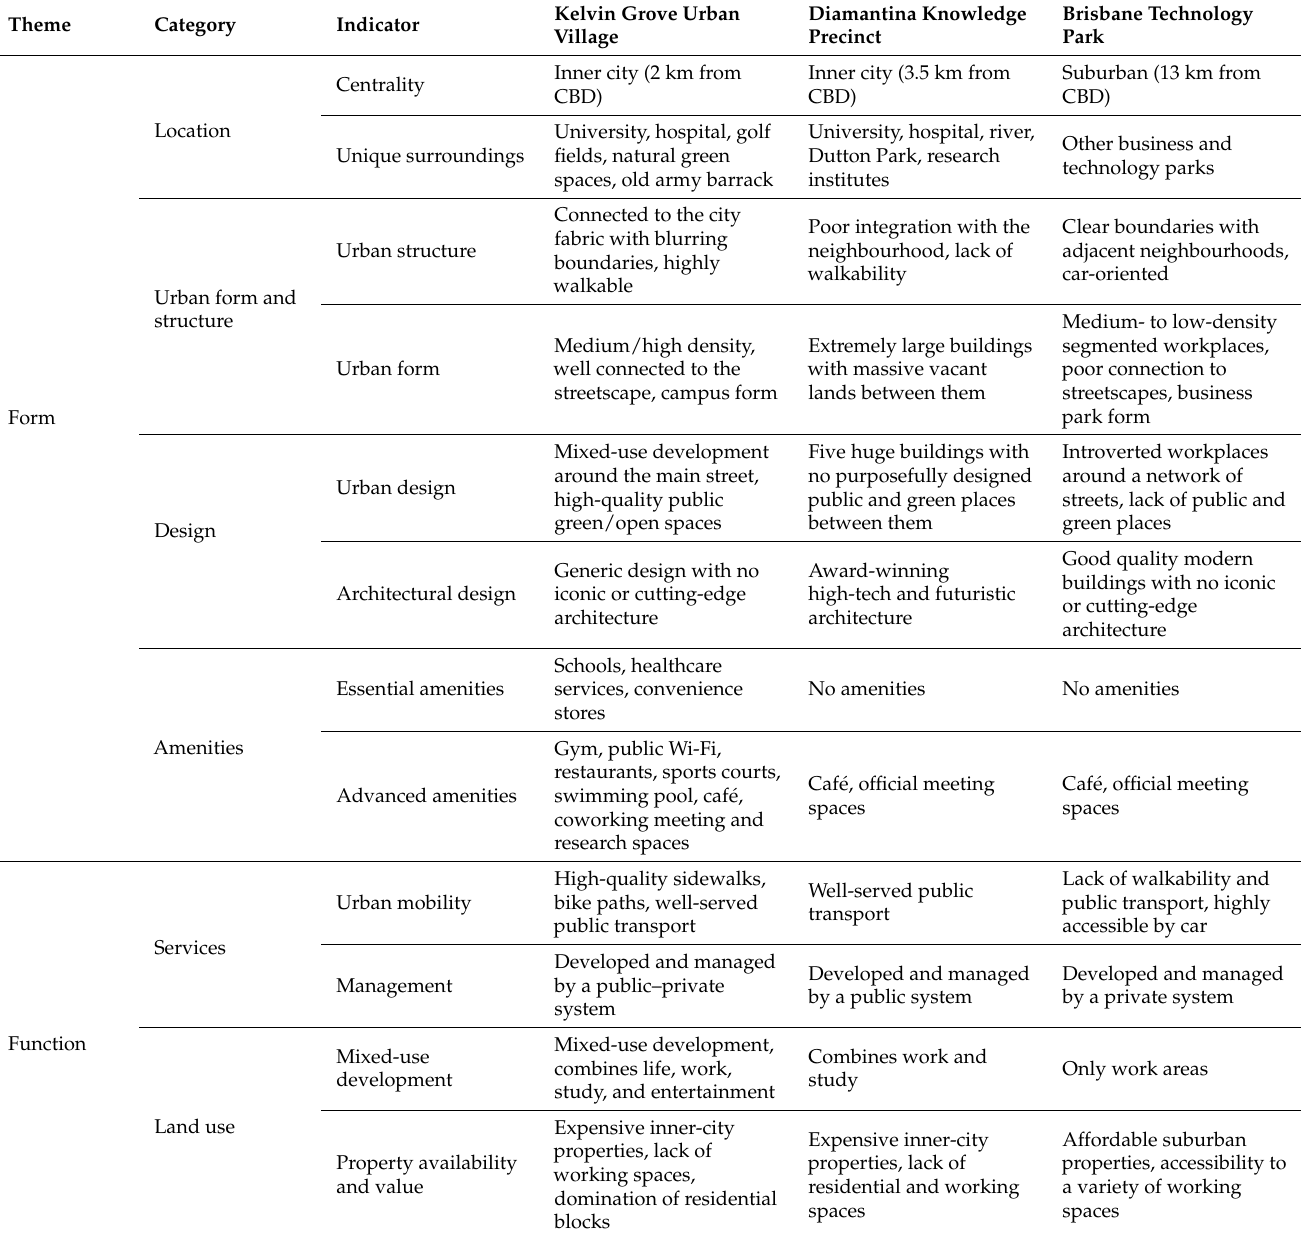
Table 1. Key characteristics of case study innovation